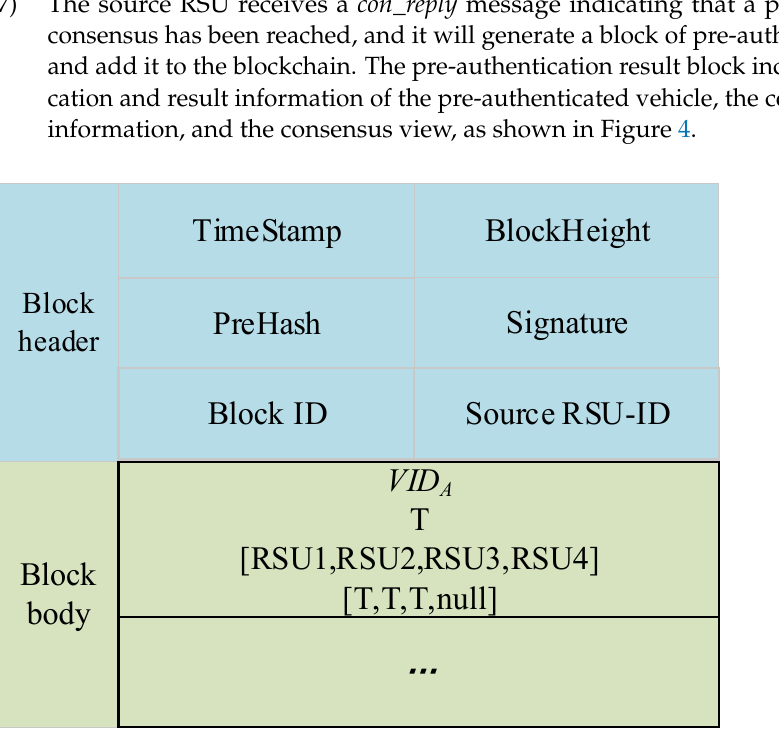
Figure 4. Pre-authentication block structure.